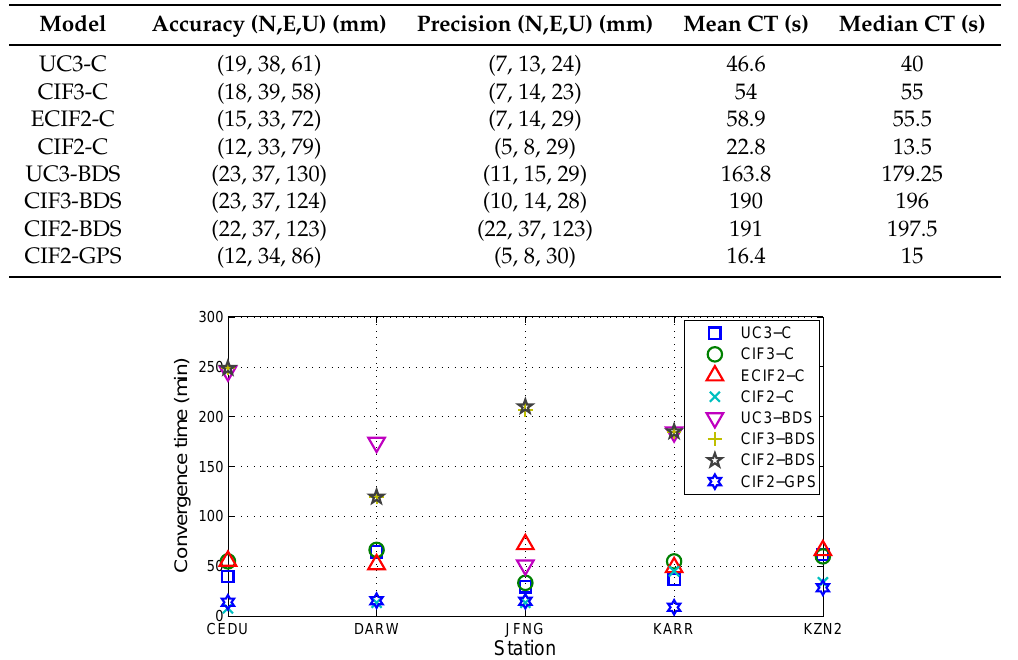
Table 7. Mean accuracy, mean precision, mean convergence time, and median convergence time (CT) for different combined models with the daily solution at different stations. Model